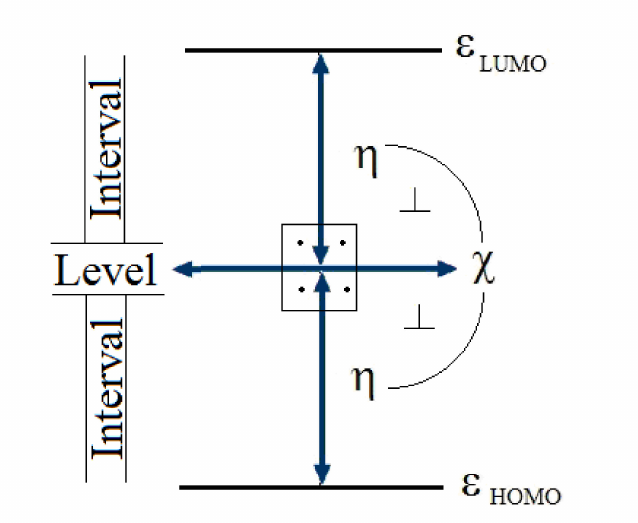
Figure 1. Electronegativity ( χ ) and chemical hardness ( η ) through orthogonal phenomena and related to HOMO-LUMO